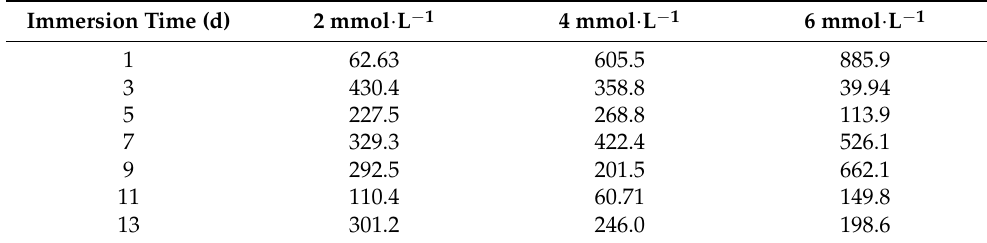
Table 4. R ct values obtained by EIS fitting of magnesium alloy AZ31B immersed in 3.5% NaCl solution with different concentrations of PO 43 −